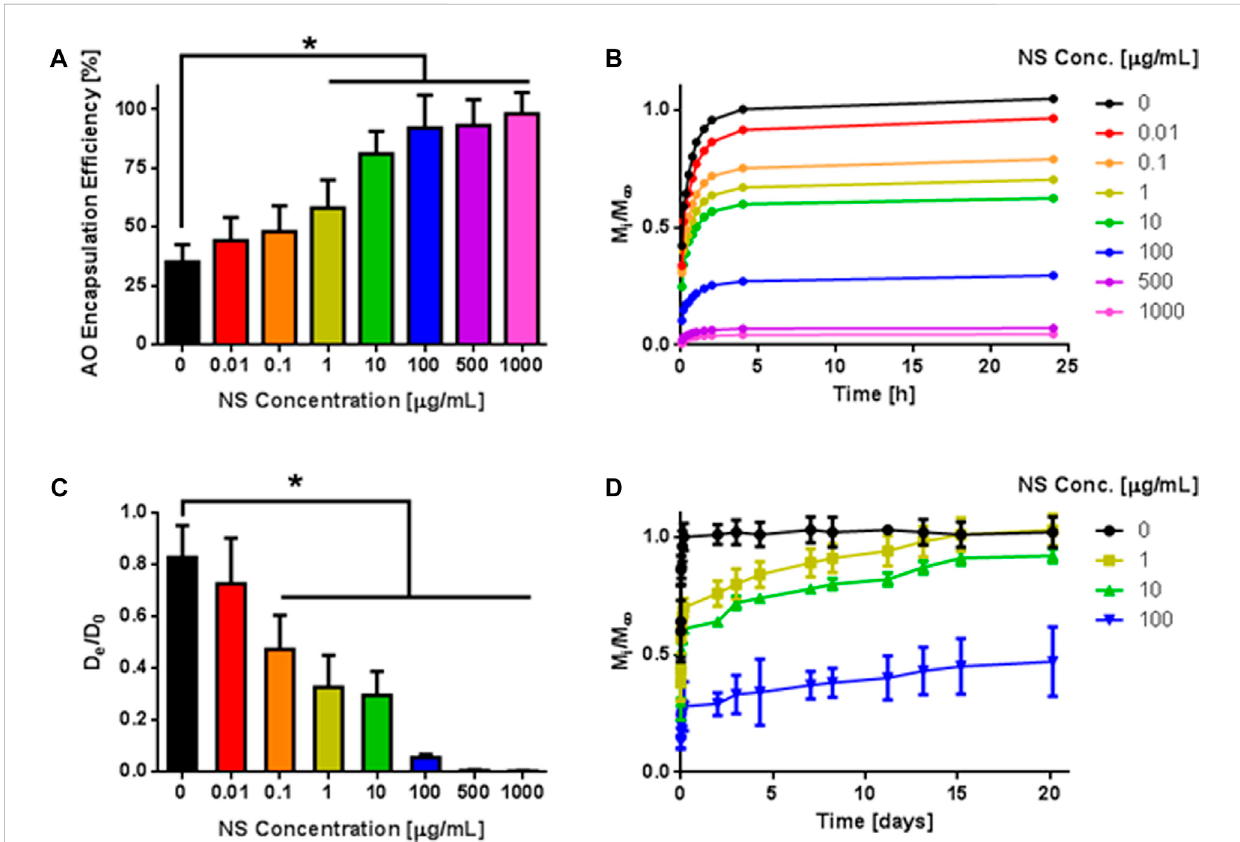
FIGURE 6 Release of AO from PEG-NS Microspheres. (A) Encapsulation ef fi ciency of AO following hydrogel microsphere fabrication. * indicates statistically signi fi cant difference from 0 μ g/mL NS group ( n = 4, p < 0.05). (B) Fractional release pro fi les of AO from microspheres containing varying concentration ofNSovershortreleasetimes.Errorbarsareomittedheretoimproveclarityofgraph( n =4). (C) Calculated diffusivitiesbasedonEq.4anddatafrom (B) * indicates statistically signi fi cant difference from 0 μ g/mL NS group ( n = 4, p < 0.05). (D) Fractional release pro fi les of AO from microspheres containing varying concentration of NS over long release